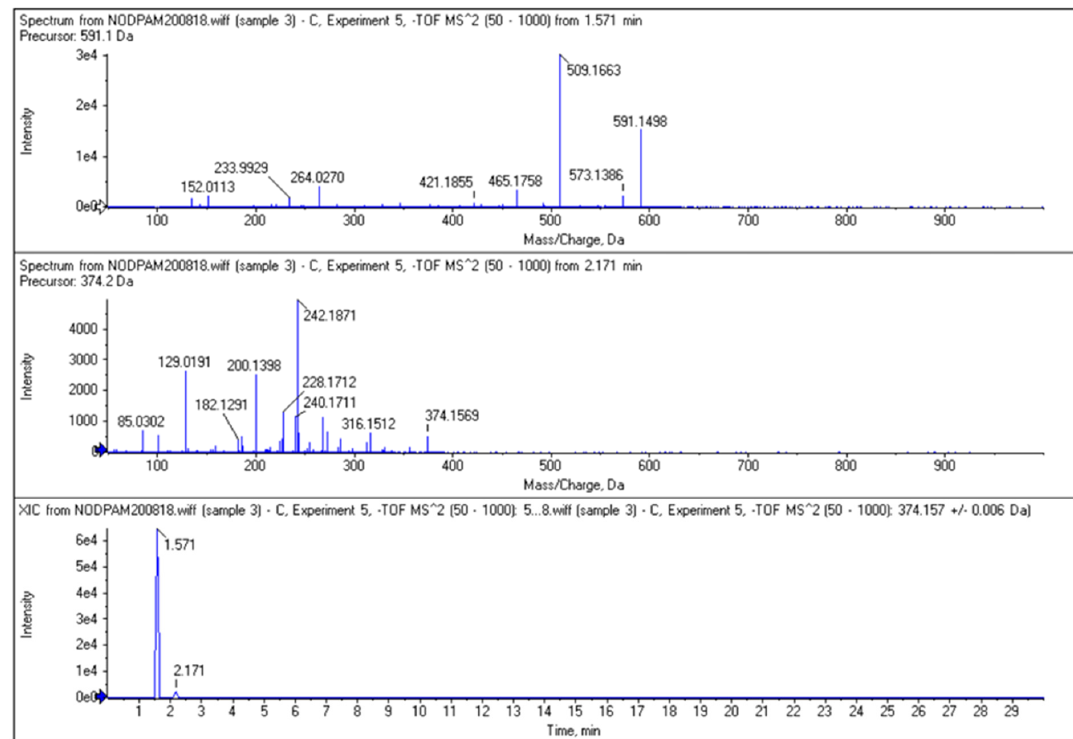
Figure 9. The MS n and the chromatogram of the NODPAM ([M − H] − m / z 591.15, RT = 1.571 min) precursor showing the presence of unreacted NODAGA chelator ([M − H] − m / z 374.16, RT = 2.171 min) in the LC-MS n analysis.